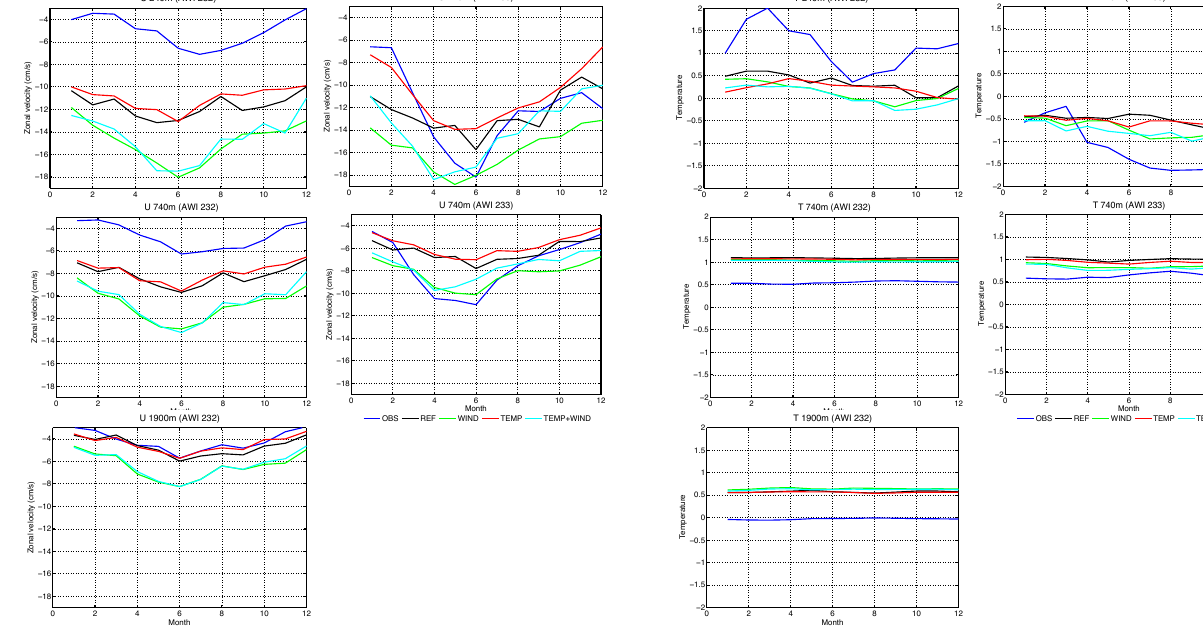
the bathymetry line 3500 m (which is the depth of PET). As